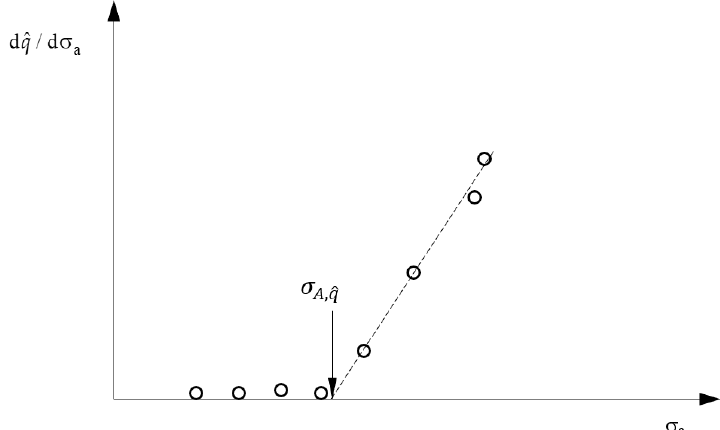
Figure 7. Rapid material fatigue limit evaluation according to the “phase lock-in method” [12].